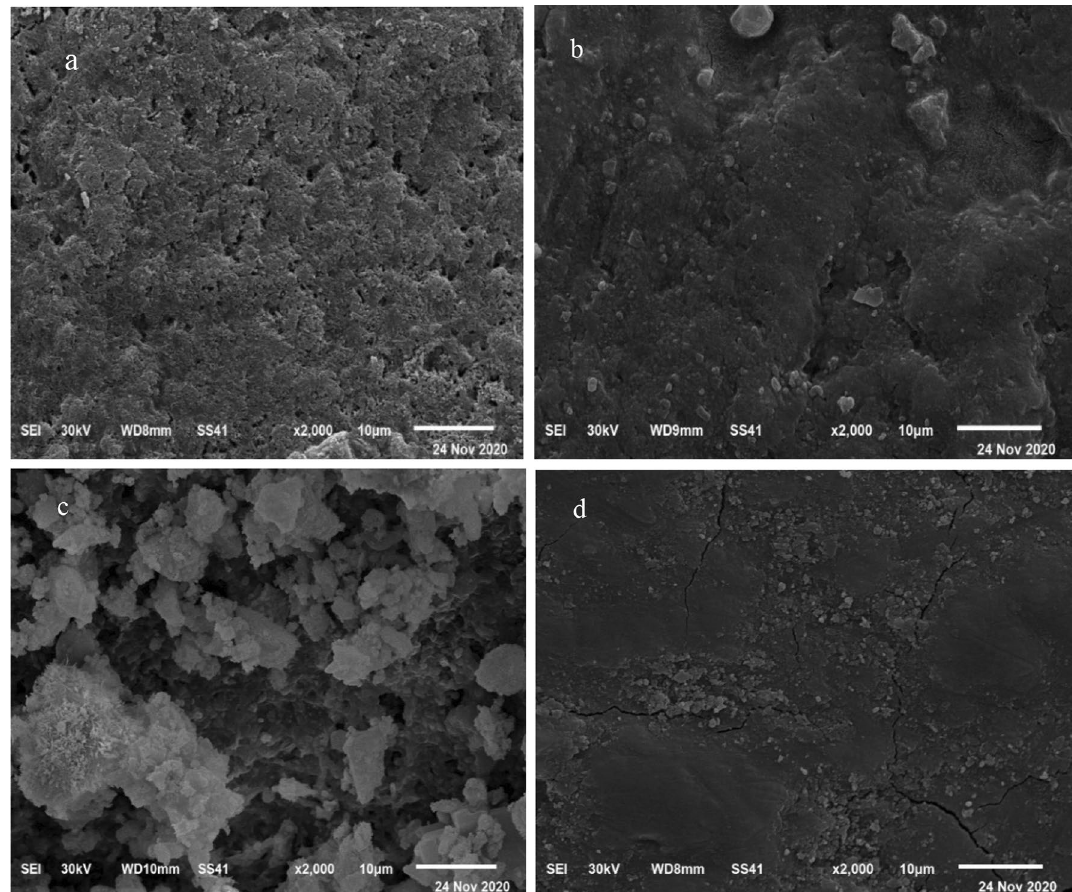
Figure 5. ( a ) SEM micrograph of a demineralized enamel surface. ( b ) SEM micrograph of an enamel substrate treated with CPP-ACP. ( c ) SEM of an enamel substrate treated with SDF-KI. ( d ) SEM micrograph of an enamel substrate treated with prepared